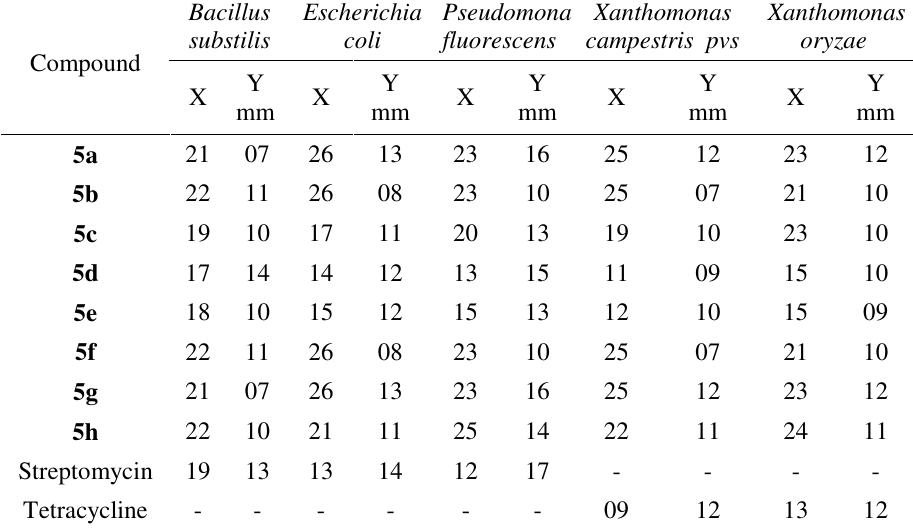
Table 1. Minimal inhibitory concentration in µg mL -1 [ X ] and Inhibitory zone in (diameter) mm [ Y ] of the synthesized compounds against tested bacterial strains by micro dilution method and disc diffusion method respectively